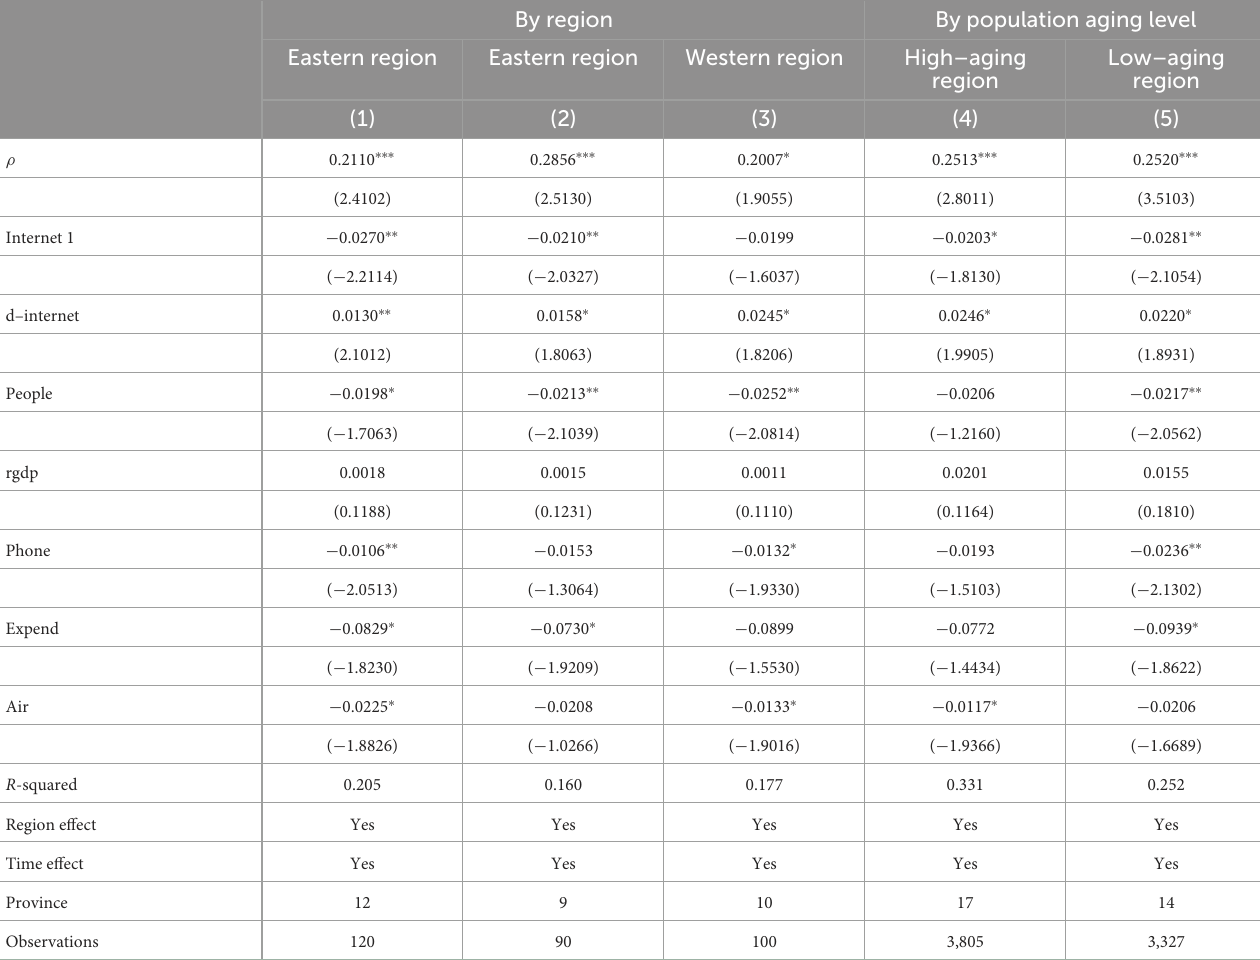
TABLE 5 Results of heterogeneity